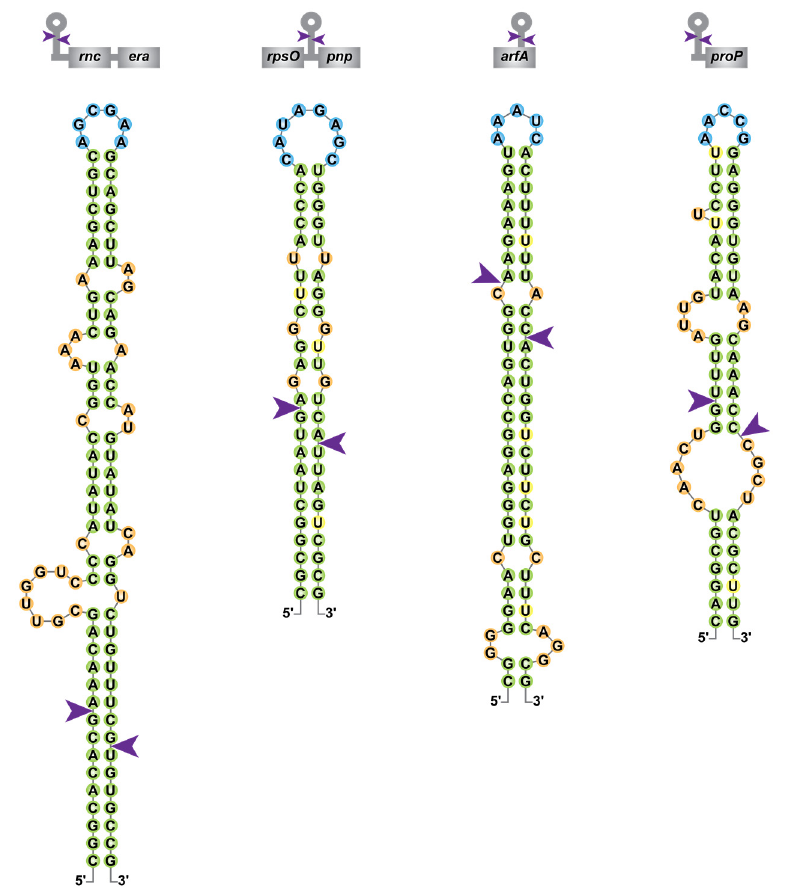
Figure 3. Diversity of RNase III cleavage sites within E. coli mRNAs. Secondary structure predictions of Ec-RNase III targets within the rnc - era , rpsO - pnp , arfA and proP mRNAs were obtained from [49,55,62,70] and color-coded as in Figure 2. A schematic representation of the targeted mRNAs is presented on top of each RNA structure with coding sequences in grey